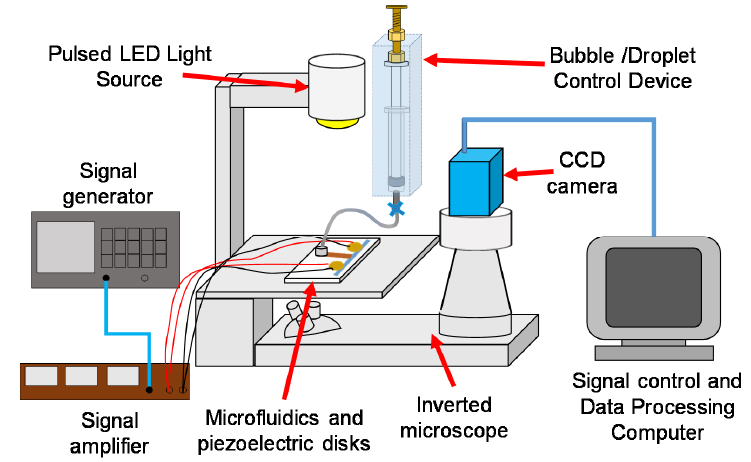
Figure 3. Experimental setup for the flow visualization and particle tracking velocimetry (PTV) measurement.